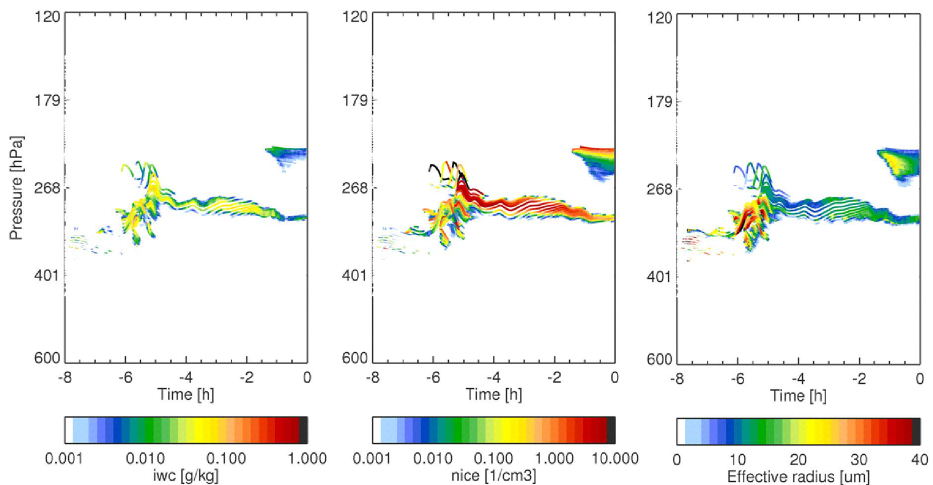
Fig. B2. Microphysical column model results for the case with superimposed small-scale temperature fluctuations showing parameters in addition to those shown in Fig. 5. Left panel: ice water content, IWC . Centre panel: ice number density, n ice . Right panel: effective radius of the ice crystals, r eff .